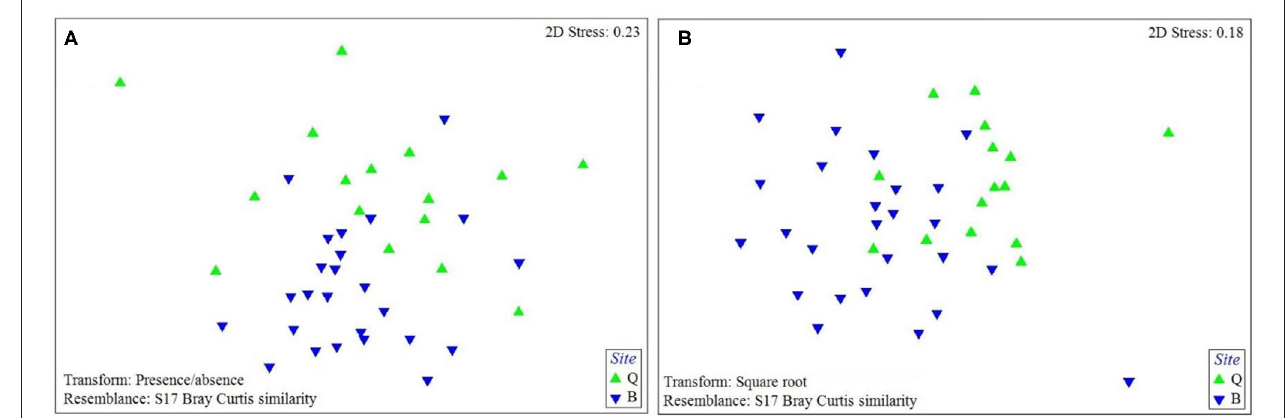
FIGURE 4 | The nMDS plot of (A) the species composition and (B) assemblage structure of sea turtle epibionts at each study site based on Bray-Curtis similarity matrix performed on presence-absence data for species composition and square-root transformed data for assemblage structure (Q: Shibderaz, Qeshm Island; and B: DNNP, Bushehr